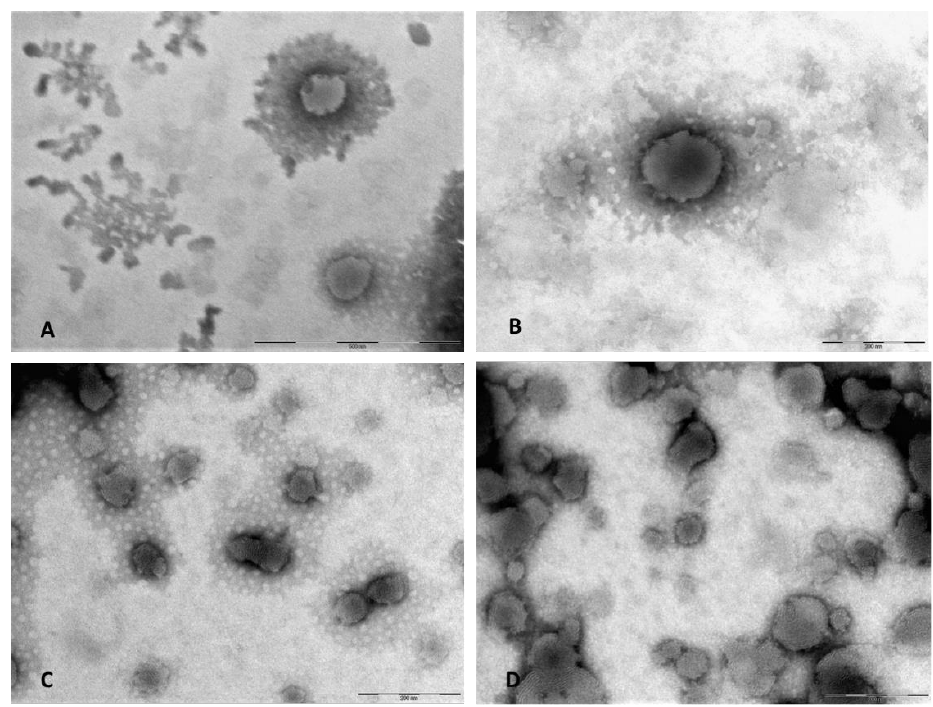
Figure 2. TEM pictures of BRB-L before ( A ) and after dialysis process ( B ), and of BRB/TAR-L before ( C ) and after dialysis process ( D ).